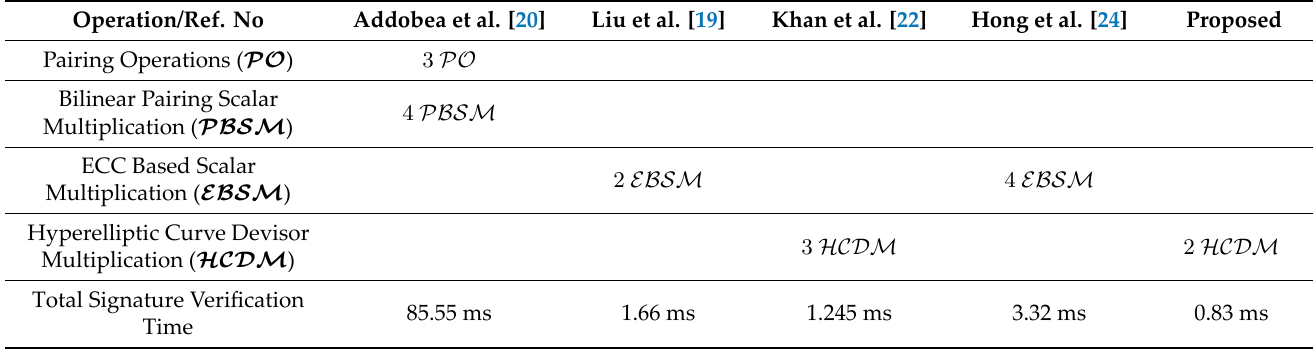
Table 5. Computation of the costs of both online and offline signature